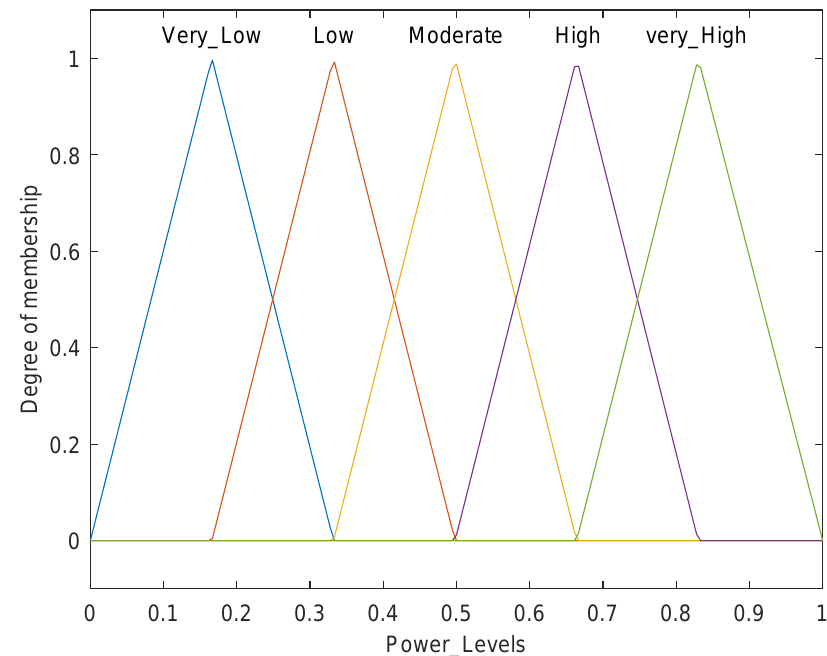
Figure 6. Membership function (MF) plot for output variable power